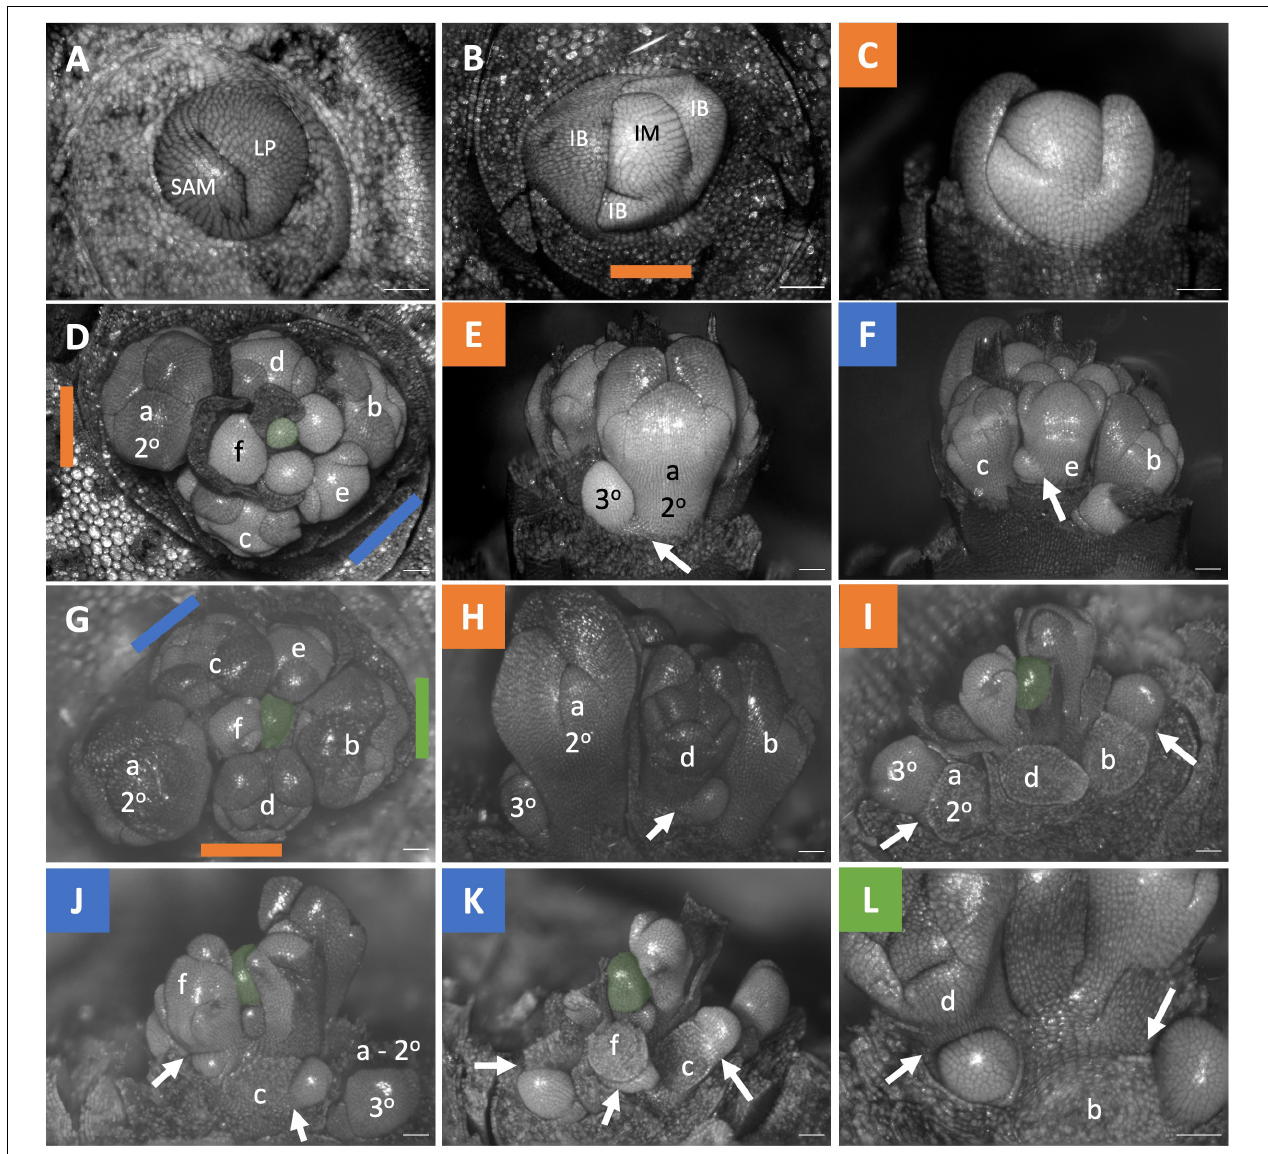
FIGURE 4 | Dichelostemma × venustum “Pink Diamond” inflorescence developmental morphology. (A) Shoot Apical Meristem. (B,C) Inflorescence meristem imaged from the apex (B) and laterally (C) . (D–F) Young inflorescence meristem imaged from apex (D) and laterally (E,F) . (G–L) An older stage of inflorescence meristem. Imaged apically (G) and laterally (H–L) . The first 6 second-order flowers lettered a–f indicating sequence of initiation (D–L) . Branching order (2 ◦ , 3 ◦ ) labeled only for the cyme of the first flower initiated a. Colored bars on images taken from the apex (B,D,G) indicate orientation of subsequent lateral images. Structures only labeled in first apical image. SAM, shoot apical meristem; LP, leaf primordia; IM, inflorescence meristem, false colored green (D–L) ; IB, Inflorescence bract; FP, floral primordia; fb, floral bract. White arrows indicate branching events between second and third order branches. Scale bar of all images: 100 µ